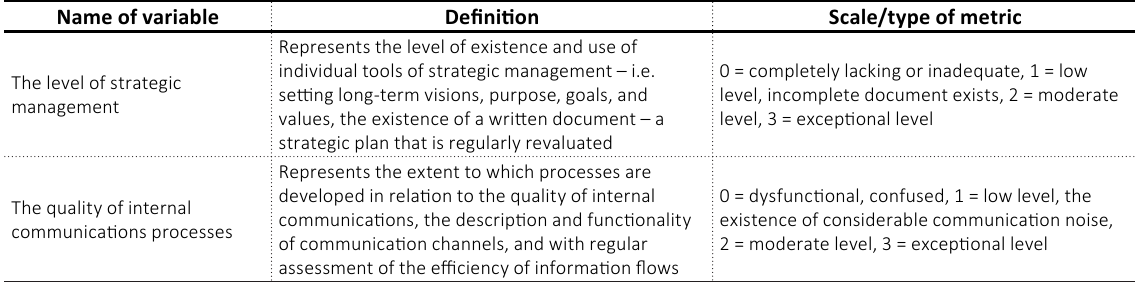
Table 1. Description of variables